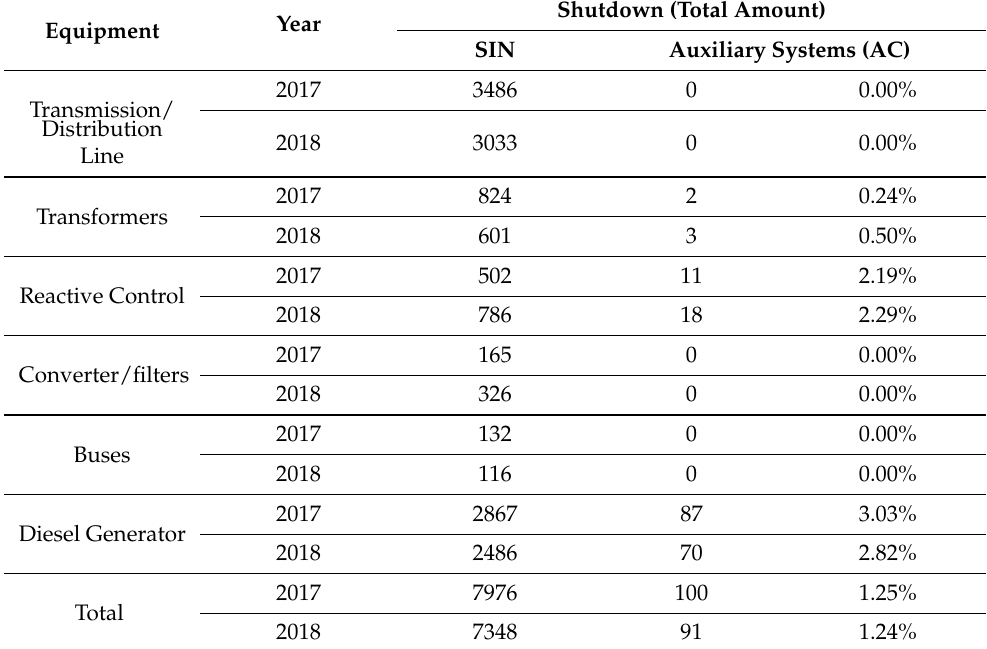
Table 1. SIN faults associated with the supply of substations’ auxiliary systems